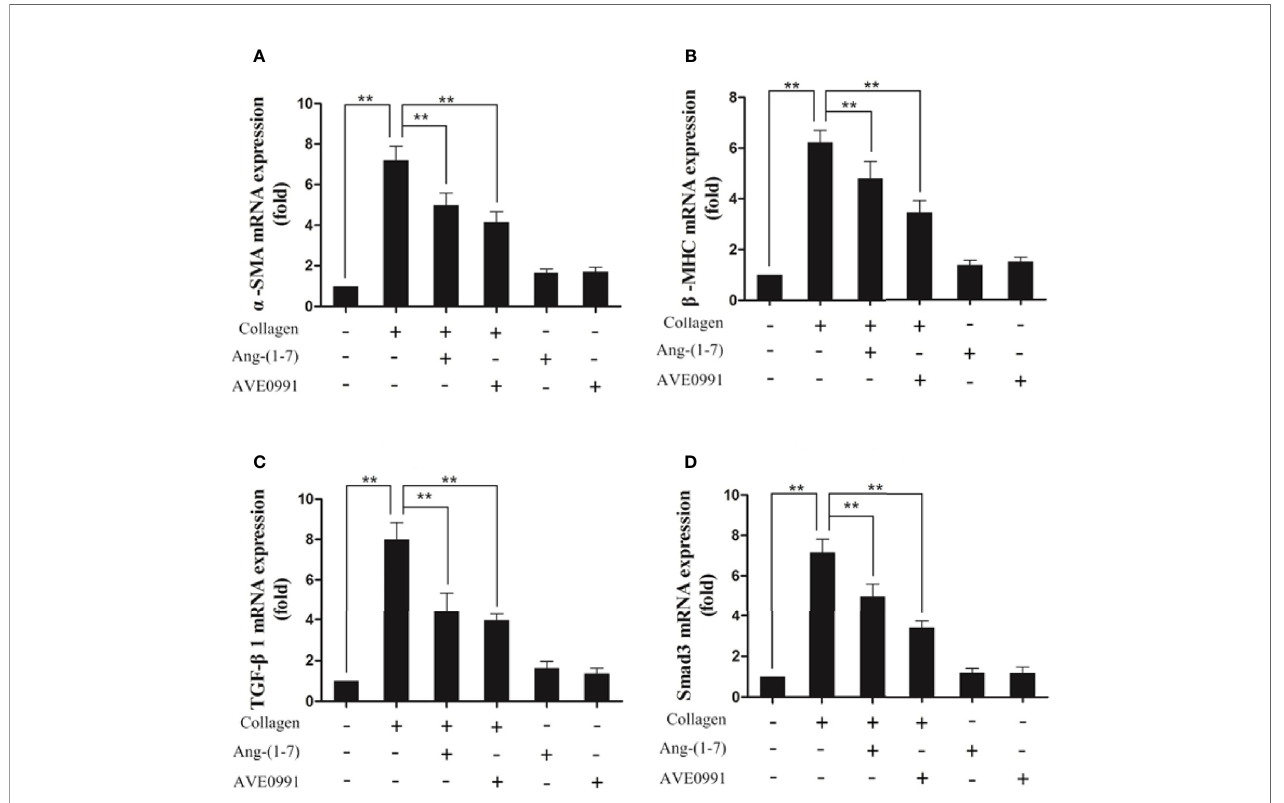
FIGURE 8 | Ang-(1 – 7) and AVE0991 inhibit arthritis-induced a -SMA 、 b -MHC 、 TGF- b 1, and Smad3 mRNA expression in the heart. The mRNA expression of (A) a -SMA, (B) b -MHC, (C) TGF- b 1 and (D) Smad3 was detected by real-time PCR. Relative gene expression was calculated using the 2 ¯ △△ CT method; the GAPDH gene served as the internal control. Values are expressed as means ± SD (n = 6),